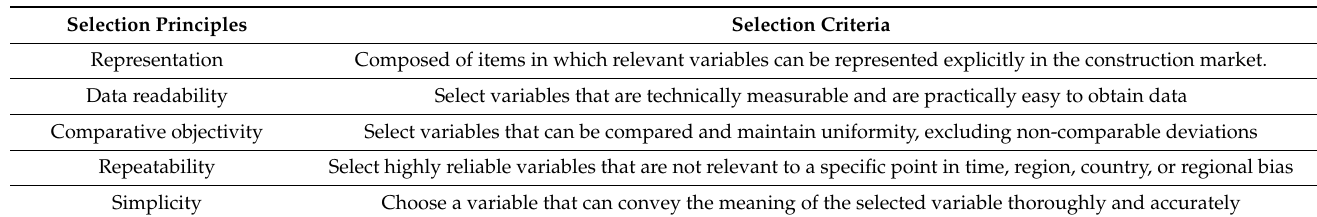
Table 4. Model composition variable selection principles and criteria.